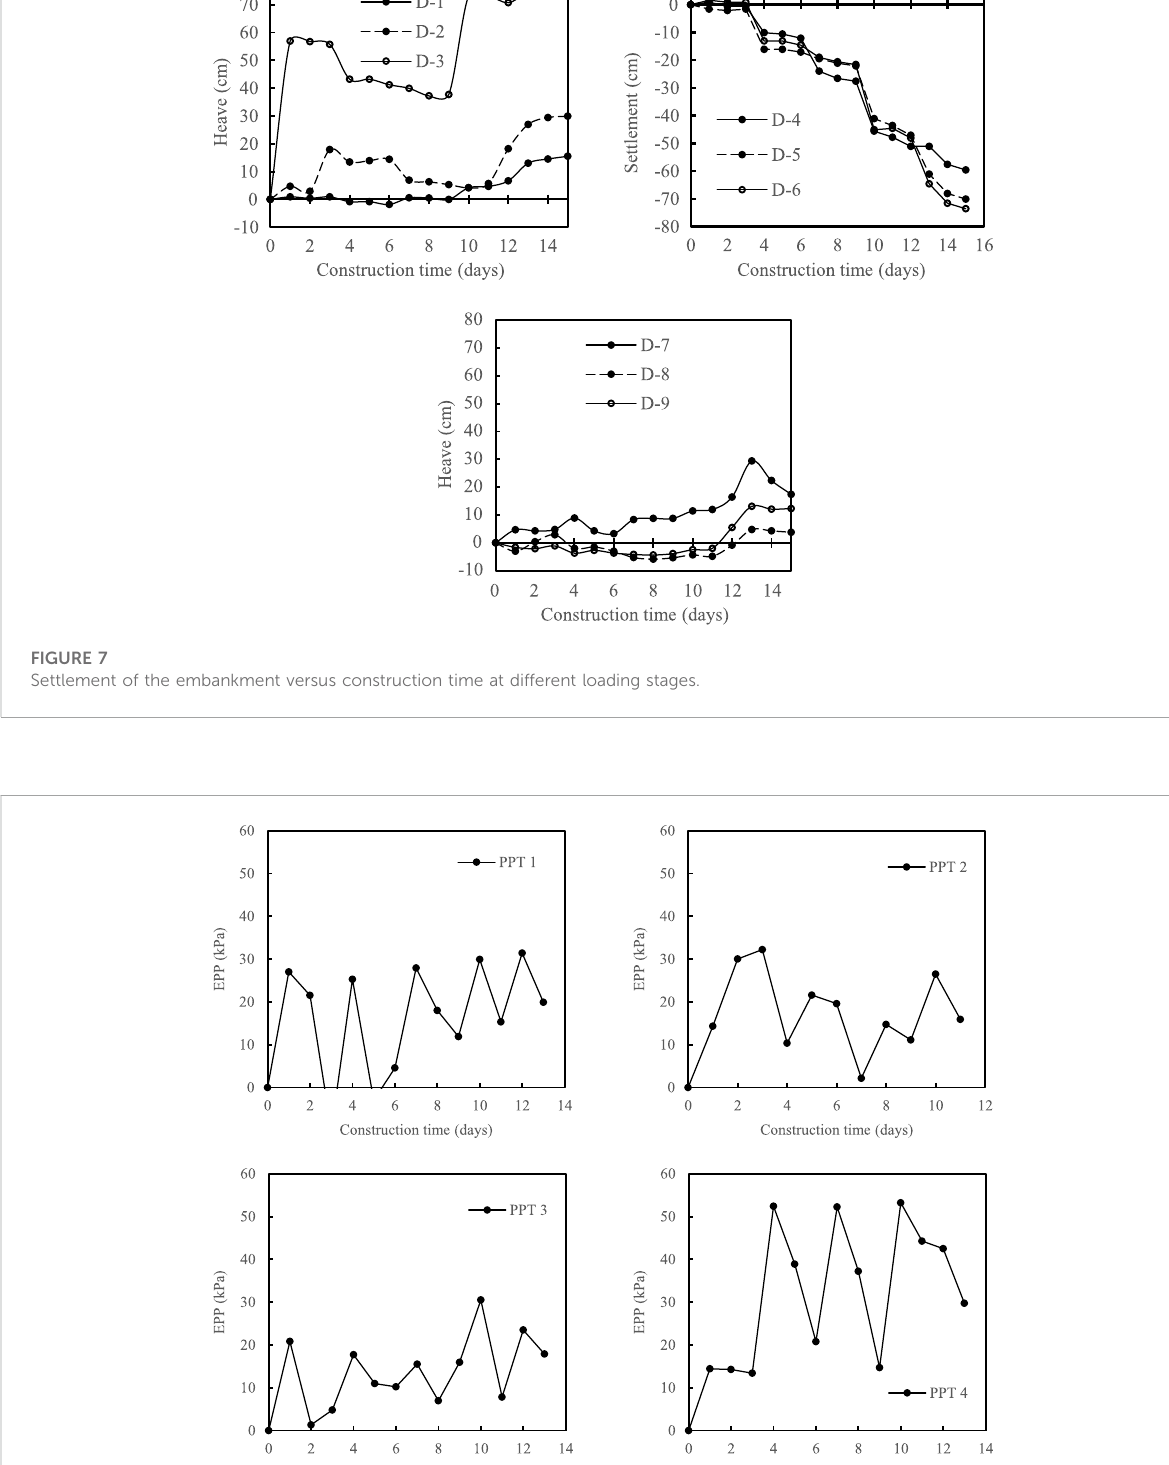
FIGURE 8 Excess pore-water pressure (EPP) of the soil versus the construction time.